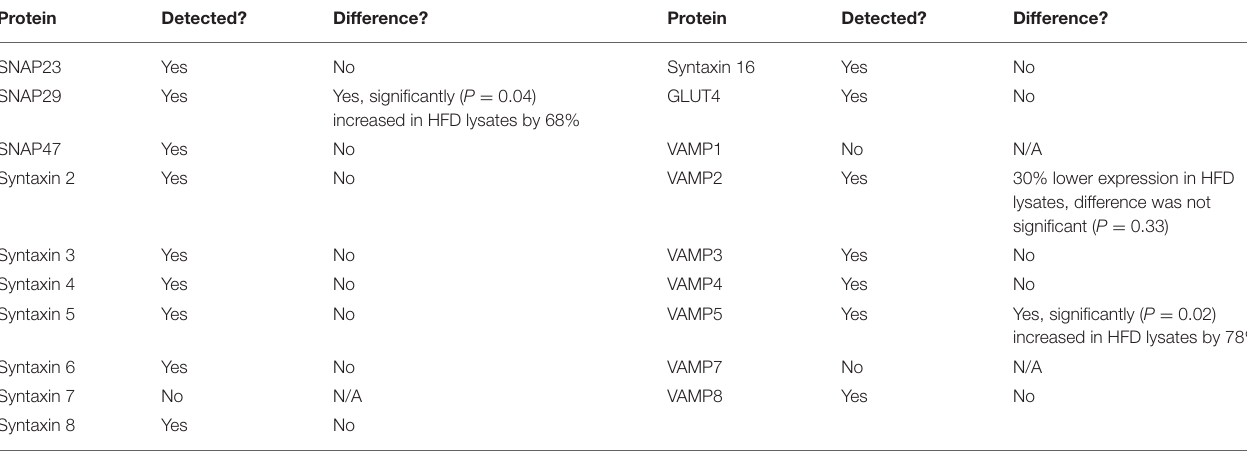
TABLE 2 | Quantification of SNARE protein expression in HFD primary cardiac lysates. Protein Detected? Difference? Protein Detected? Difference?